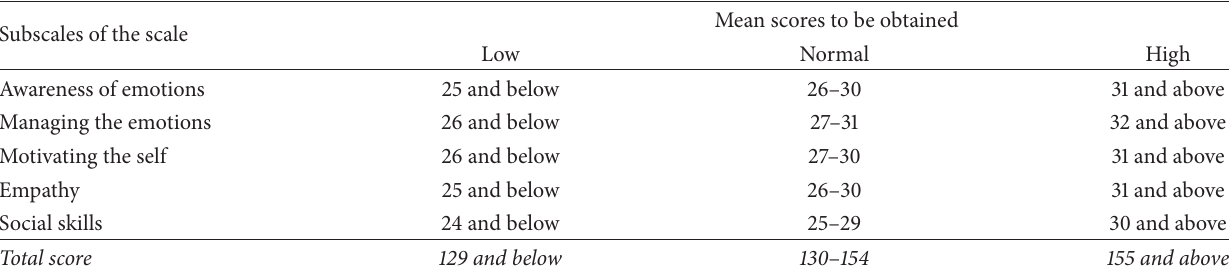
Table 1: Scoring of the Emotional Intelligence Evaluation Scale.